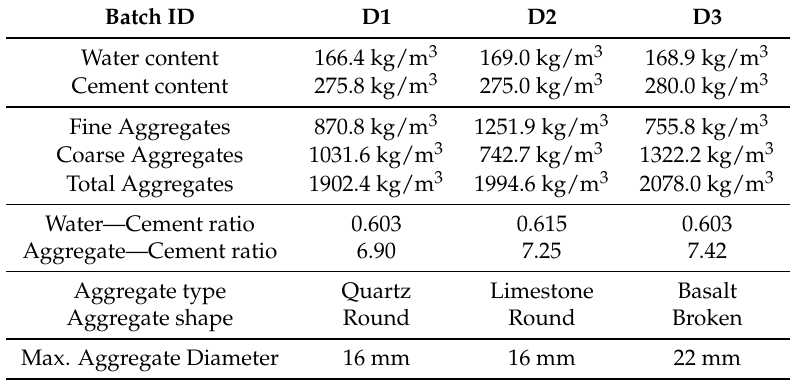
Table 1. Differences of mix design between batches. Fine aggregates are defined as the aggregates with size until 4 mm, the coarse ones are the rest of the